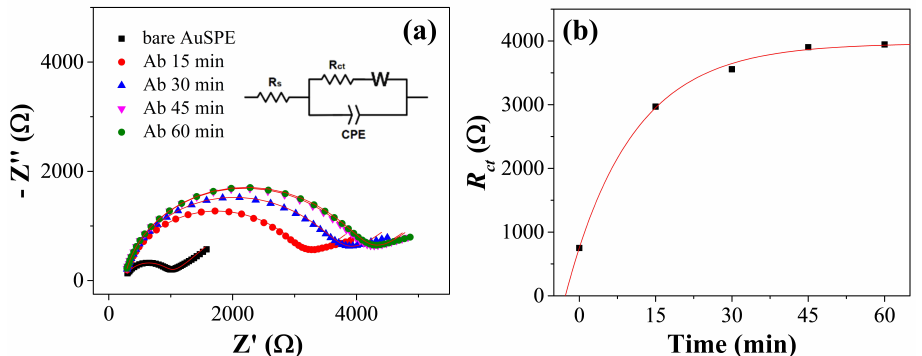
Figure 3. ( a ) EIS spectrum measured at di ff erent times while the UV irradiated antibodies are conveyed to the interaction cell; ( b ) R ct as a function of time showing that the surface saturation takes place within one-hour time. The errors of R ct are within the thickness of the experimental